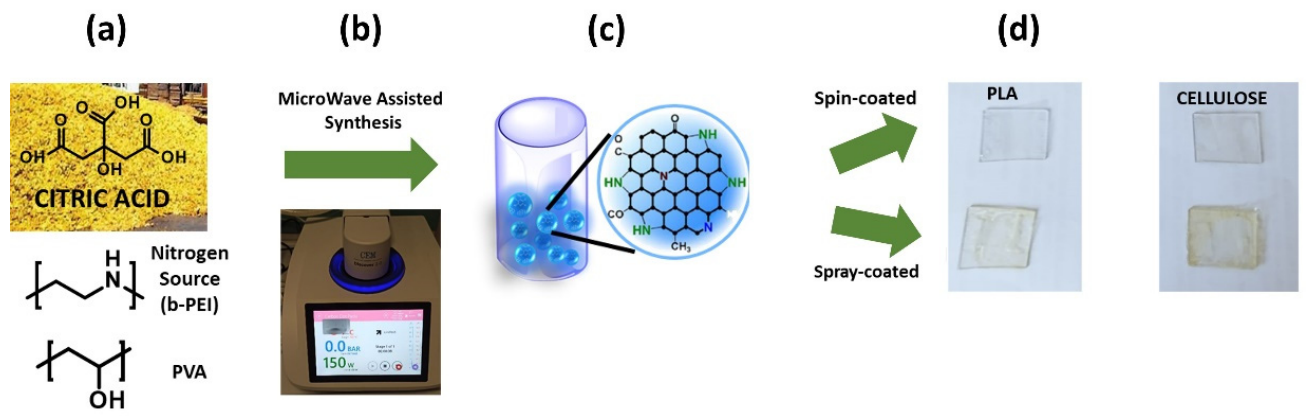
Figure 1. Schematic representation of the CDs:PVA-coated films preparation: ( a ) Citric acid, b-PEI, and PVA are mixed; ( b ) synthesis assisted by MicroWave; ( c ) formation of CDs; ( d ) PLA and cellulose films coated with the spin- or spray-coating techniques.